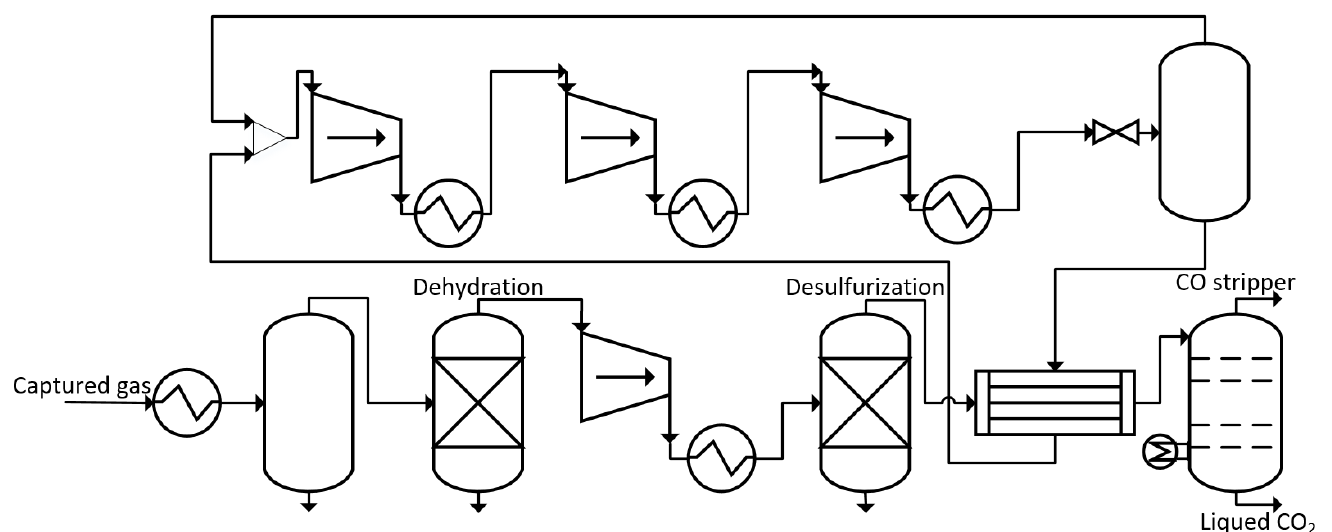
Figure 8. Process flow diagram for the closed-cycle liquefaction design.